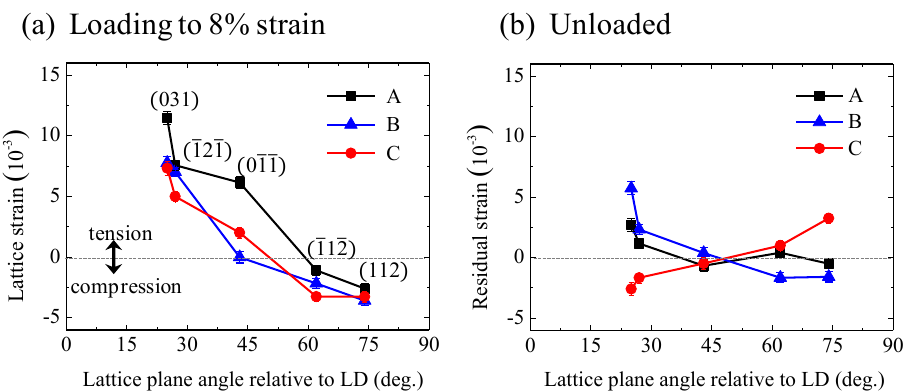
Figure 7. ( a ) Lattice strain at 8% strain and ( b ) residual strain after unloading, measured at three different positions (A, B, and C) in a